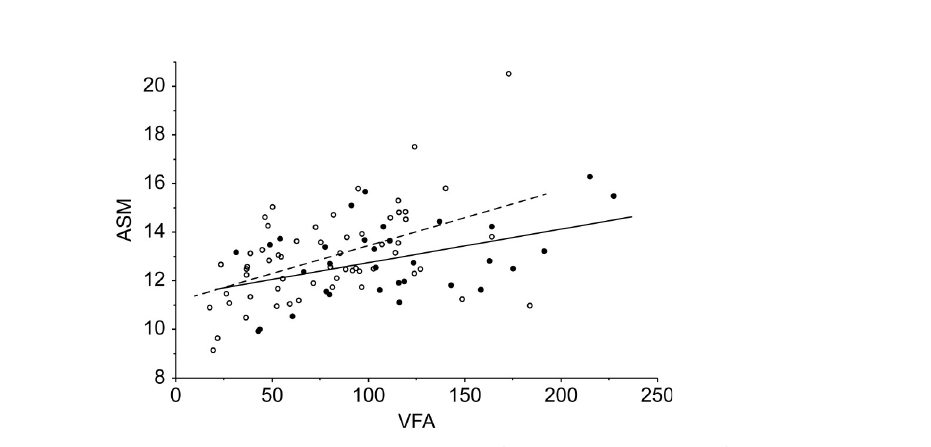
PLOS ONE | https://doi.org/10.1371/journal.pone.0243242 December3,